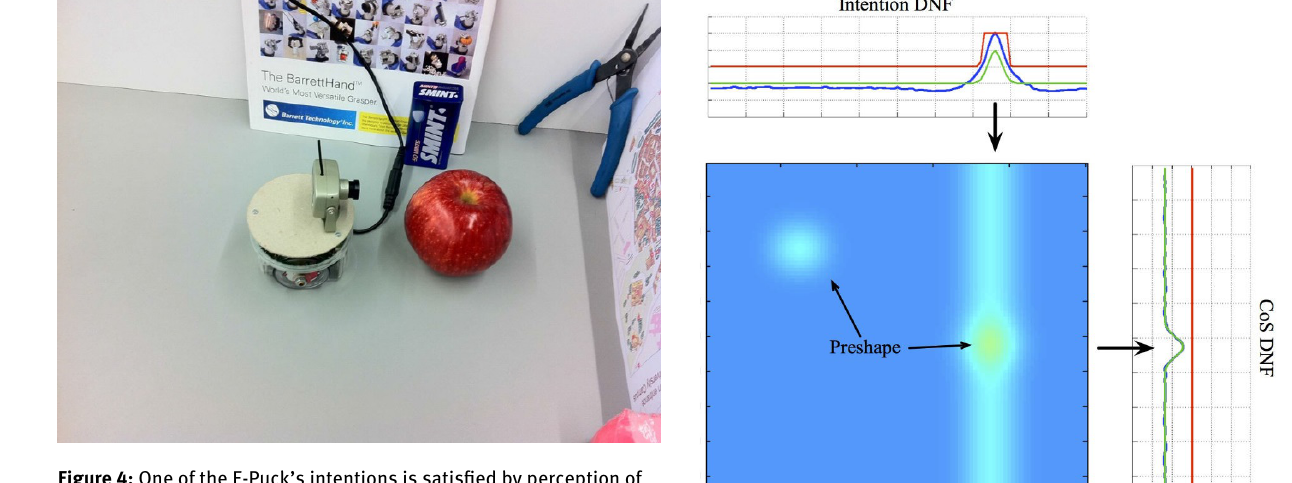
Figure 4: One of the E-Puck’s intentions is satisfied by perception of the color red. If that intention were active, this would be a reward- ing state for the robot. If the other intention were active, this would not be rewarding. When the reward signal is positive, all colors de- tected in the image are gradually associated with the CoS for that intention. It is essential for the robot to see different background colors. Of course, if one never sees a teacup apart from its saucer, one will never understand they are two separate objects. Figure 5: Example weighted mapping between one-dimensional